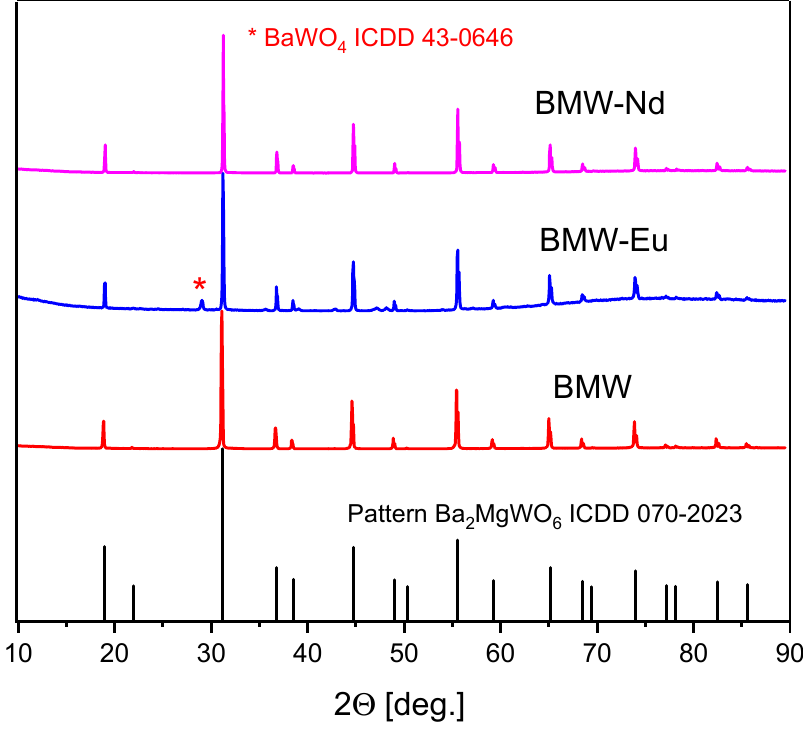
Figure 5. XRD patterns of the ceramics materials: BMW, BMW-Eu, and BMW-Nd.